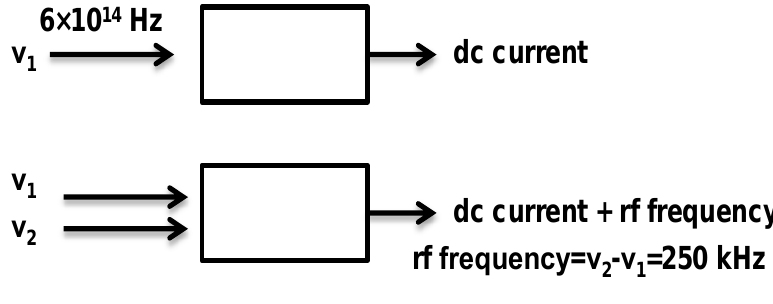
Figure 5. Conceptual diagram of optical heterodyne detection. Rectangle represents the